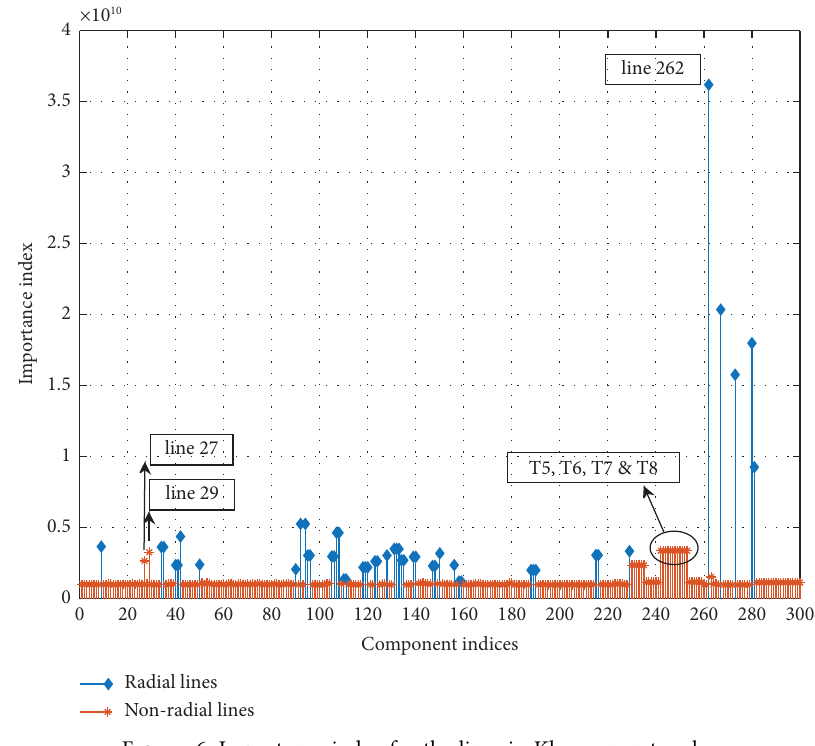
Figure 6: Importance index for the lines in Khorasan network.